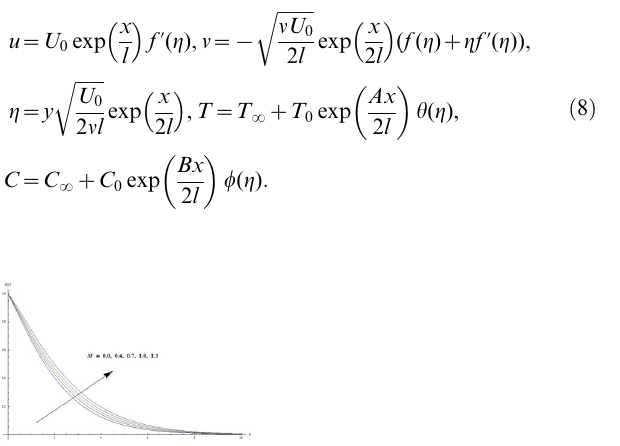
Figure 3. Variation in dimensionless temperature h ( g ) vs g for different values of M when l 1 ~ 0 : 3, b ~ 0 : 2, Pr ~ 0 : 7, Le ~ 1 : 0, Nt ~ 0 : 2 ~ Nb , Ec ~ 0 : 3 ~ Rd , A ~ 0 : 1 and B ~ 0 : 2 :